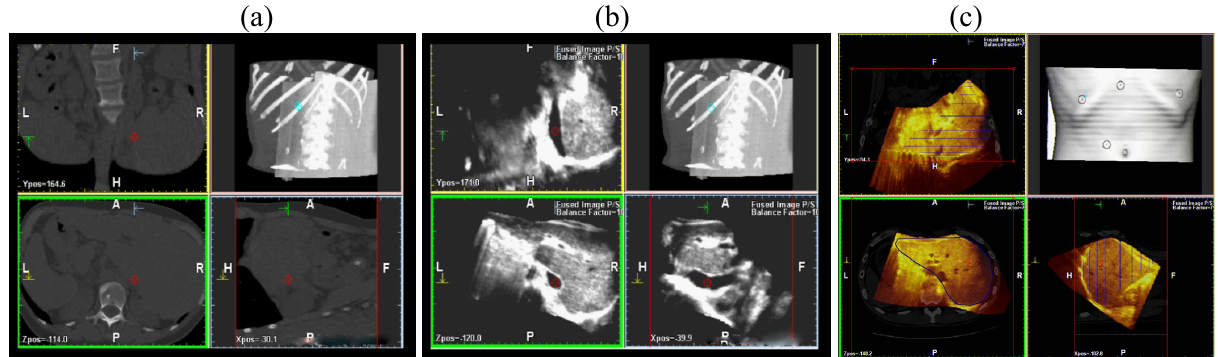
Figure 3. 3-D reconstruction of bidimensional spiral CT sequences ( a ); bidimensional US sequences ( b ); the fusion technique allows to superimpose the two volumes, showing a perfect overlapping ( c ).